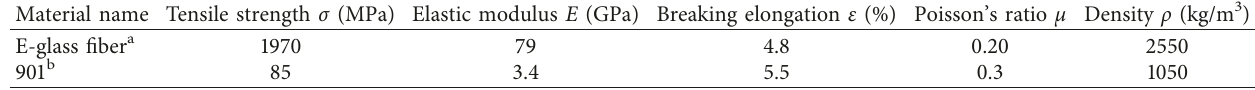
Table 2: Properties of fiber and